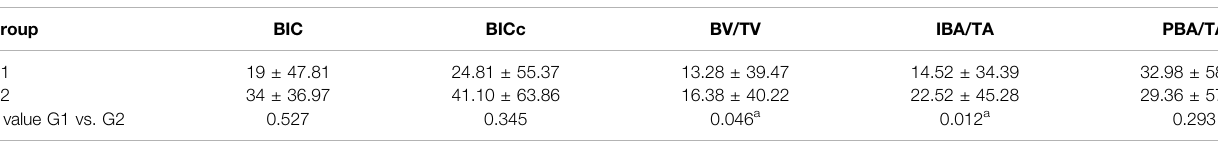
TABLE 1 | Mean, standard deviation and p value in the groups for the different parameters.